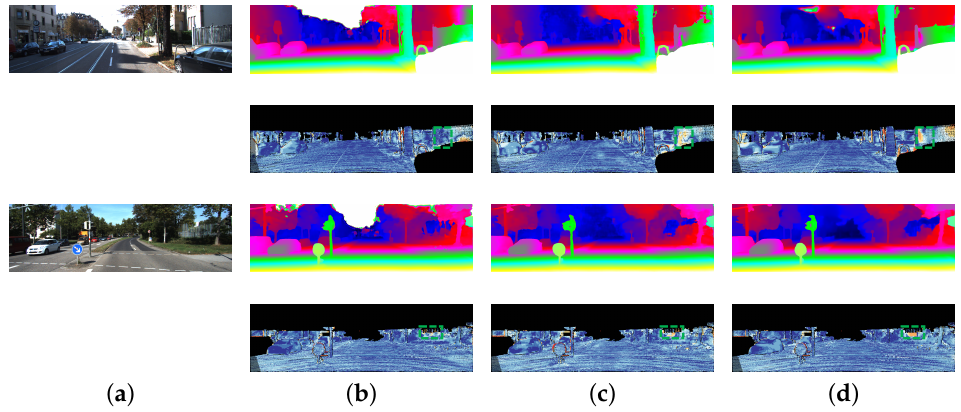
Figure 5. Results of disparity estimation for KITTI 2015 test images. Our method has great ad- vantages in processing foreground pixels, as shown in the green areas. ( a ) Left Image. ( b ) JDCNet. ( c ) PSMNet. ( d )